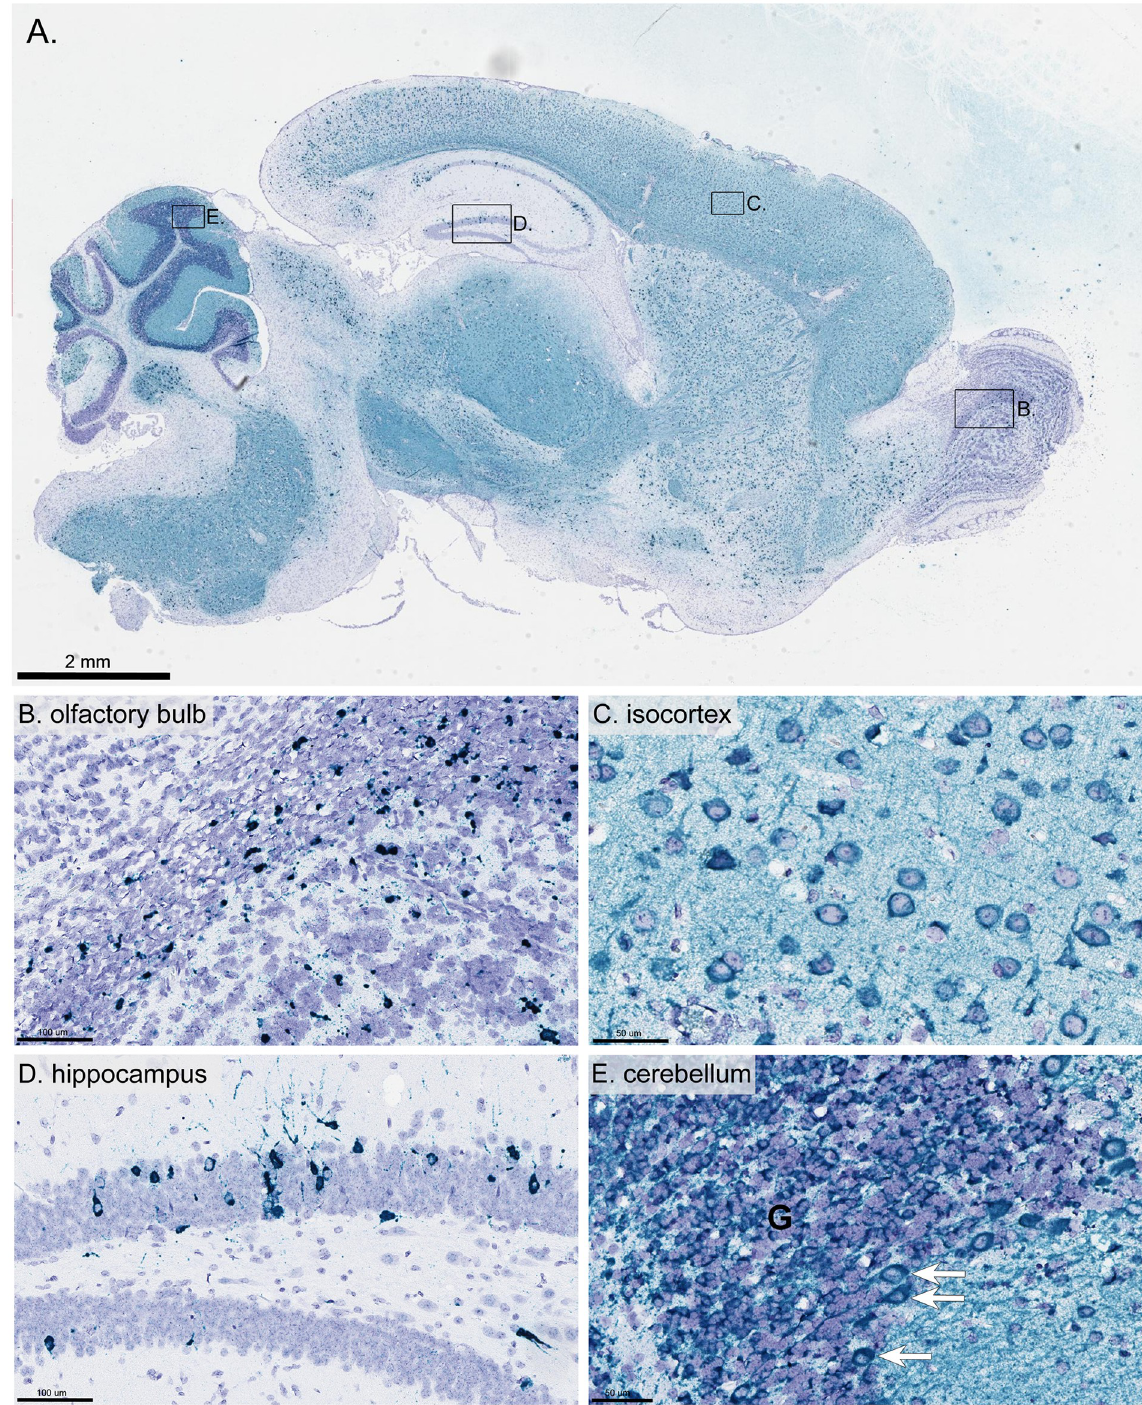
Fig 6. Distribution of positive-sense viral RNA in the brain of a mouse inoculated with 10 3 FFU DTV by RNA in situ hybridization. This tissue was harvested from a moribund mouse at 7 dpi and stained for positive-sense POWV RNA (blue-green stain) and counter-stained with Hematoxylin (purple). A ) Whole brain sagittal cross-section. B ) Olfactory bulb C ) Isocortex D ) Hippocampus E ) Cerebellum (arrows point to positively-stained Purkinje cells). G = granule cell layer.